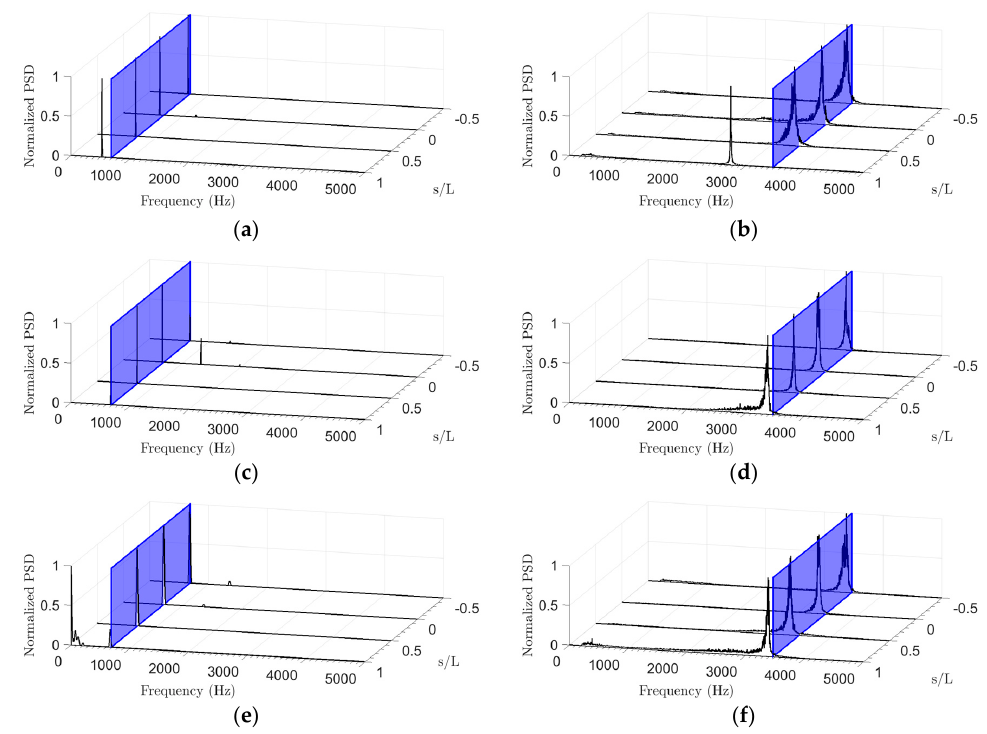
Figure 6. Normalized power spectral densities (PSD) measured at two Reynolds number values ( 𝑅𝑒 = 75: ( a , c , e ); 𝑅𝑒 = 285: ( b , d , f )) and three inclination angles (90°: ( a , b ); 45°: ( c , d ), 15°: ( e , f )). ( Re = 75: ( a , c , e ); Re = 285: ( b , d , f )) and three inclination angles (90 ◦ : ( a , b ); 45 ◦ : ( c , d ), 15 ◦ : ( e , f